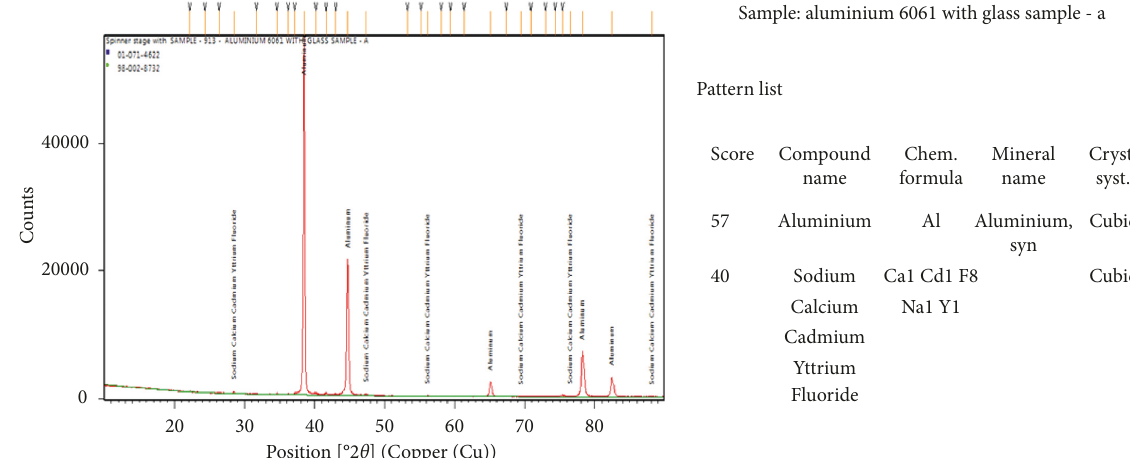
Figure 4: X-ray diffraction analysis pattern of 4% of reinforcement with glass fibre.